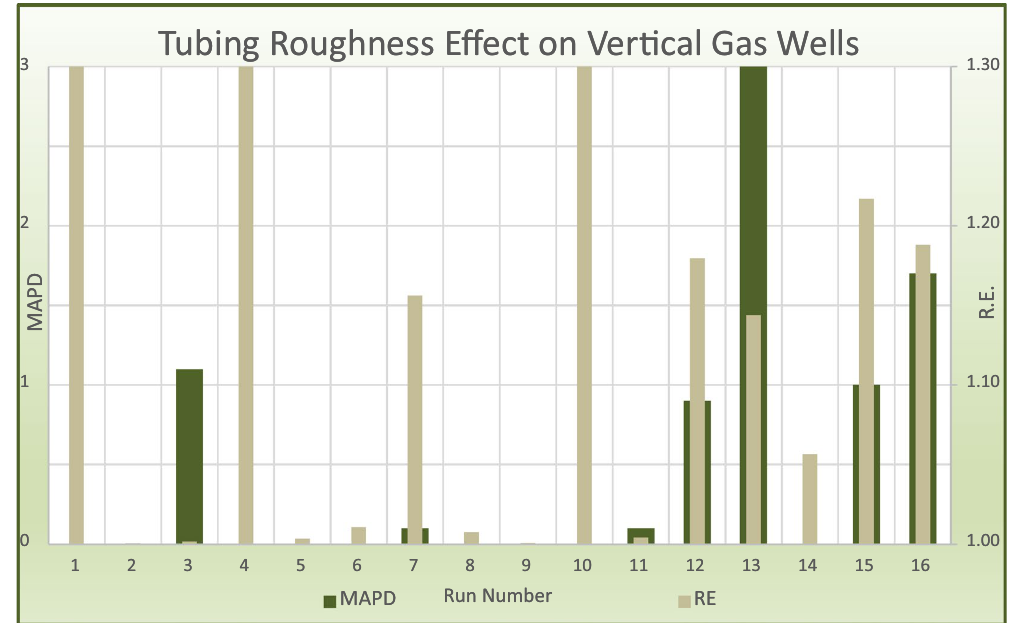
Fig. 9 Effect of tubing roughness on vertical wells using MAPD and RE